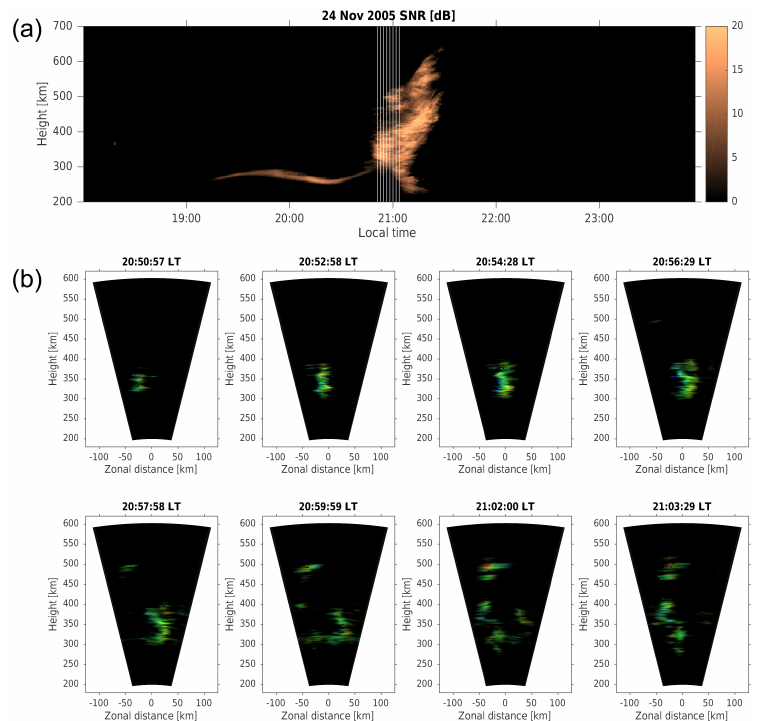
Figure 6. Panel (a) shows the RTI map of F region observations made by the São Luís radar on 24 November 2005. Panel (b) shows a sequence of images obtained with the Capon method and interferometric observations. The time for each image is indicated above each panel and as vertical white lines in the RTI